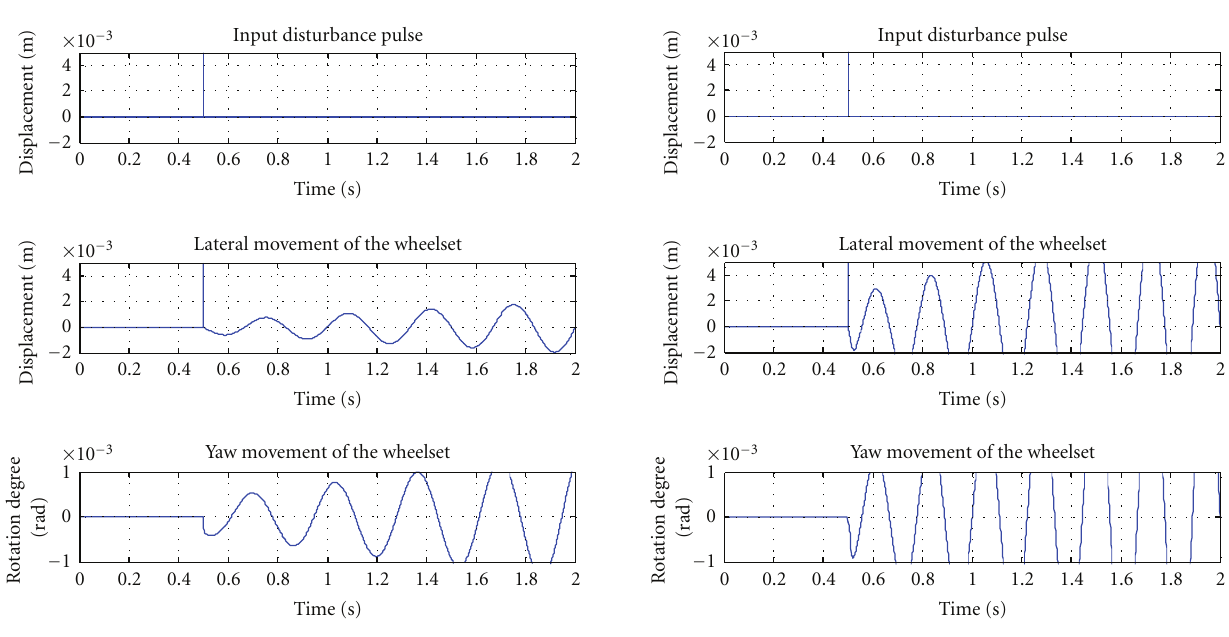
Figure 5: A wheelset without active motor control at 30m/s running speed.